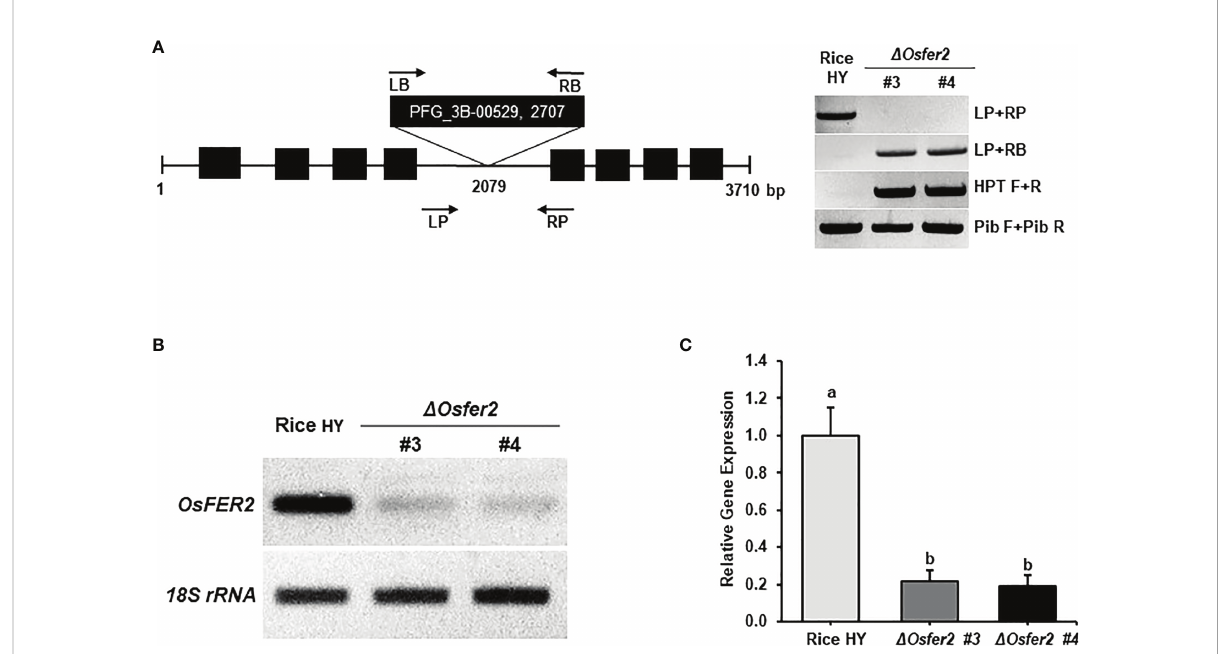
FIGURE 4 Genotyping and transcriptional analyses of D Osfer2 knock-out lines. (A) Genotyping of D Osfer2 plants. The schematic diagram illustrates the T- DNA insertion site in the OsFER2 gene. The black boxes and lines show exons and introns, respectively.The arrows indicate the orientation of T- DNA insertions from the left border (LB) to the right border (RB).The T-DNA insertion D Osfer2 mutant plants were detected using the gene primers (LP and RP) and the vector primers (LB and RB). The insertion site (2079 bp) of T-DNA was detected by sequencing. Hygromycin (HPT) primers (HPT F/R) were used for dectecting the hygromycin selection gene in the mutants. Pib (rice resistance gene) primers (Pib F/R) were used for detecting the Pib resistance gene existed in rice HY cultivar (Cho et al., 2007). LP, gene left primer; RP, gene right primer; LB, T-DNA left border; RB, T-DNA right border. (B, C) Transcriptional analyses of OsFER2 expression in rice HY and D Osfer2 knock-out lines by RT-PCR and qRT-PCR. Relative gene expression of OsFER2 in rice leaf sheaths was calculated by normalizing with respect to the expression of the internal control 18S rRNA. The data represent the means ± SDs from the three independent experiments. Different letters above the bars indicate signi fi cantly different means ( P <0.05), as analyzed by one-way ANOVA